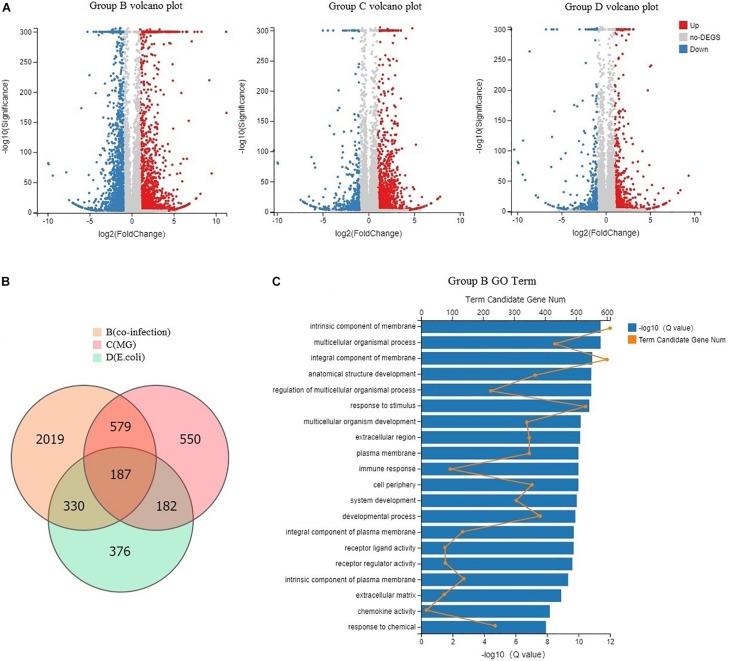
Global DEGs among infected chickens and GO function. (A) Volcano plots displaying DEGs in the three infected groups compared to the control group. Red dots (Up) represent significantly up-regulated genes; blue dots (Down) represent significantly down-regulated genes; gray dots (No) represent insignificantly DEGs (Fold Change > 2 and Adjusted P-value < 0.001). (B) Venn diagram of the three infected groups; orange represents co-infection, light pink represents MG infection, and blue represents E. coli infection. (C) GO categorization (biological process, cellular component, and molecular function) of the unigenes in the transcriptome of chicken lung induced by co-infection. The length of the X-axis column represents the size of the Q-value. The value of the point on the fold line above X is the number of differential genes annotated to the GO Term.